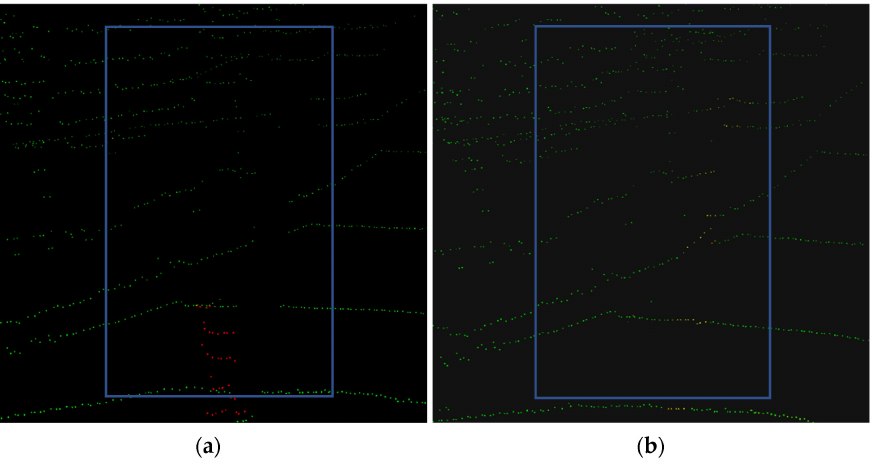
Figure 4. Pedestrian recognition and repairing. ( a ) Pedestrian points labeled with red. ( b ) Points without pedestrians, filled in with yellow.